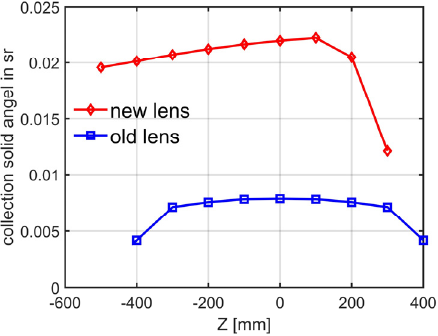
Figure 4. The collection solid angle in sr. versus Z fields in mm of the new and old lenses, respec ‐ tively.